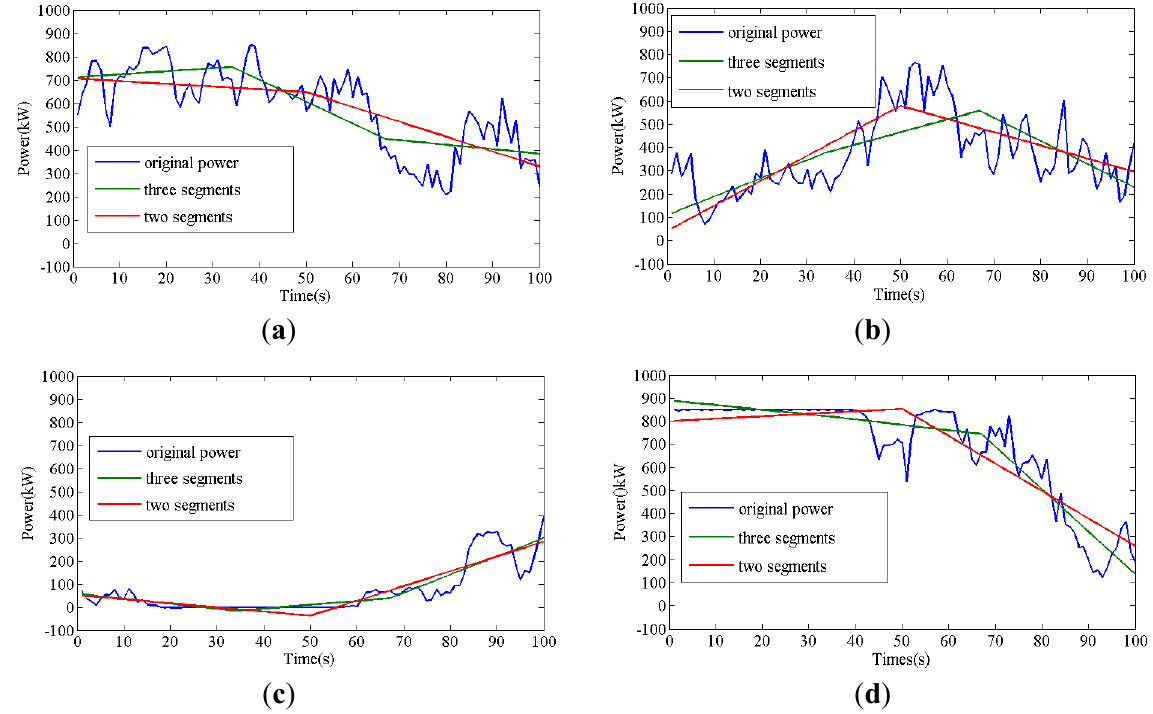
Figure 4. Regulation effect with two segments method and three segments